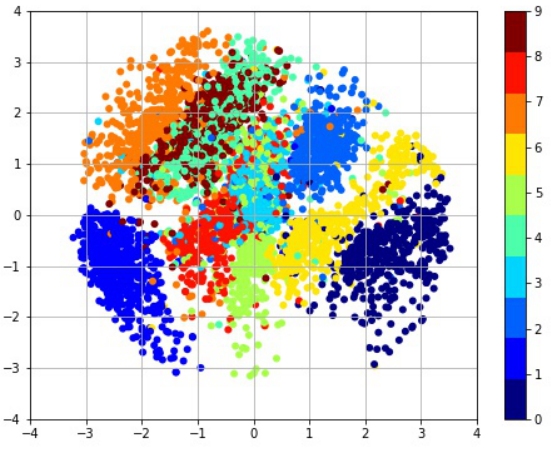
Figure 3. Visual analysis of MNIST datasets.